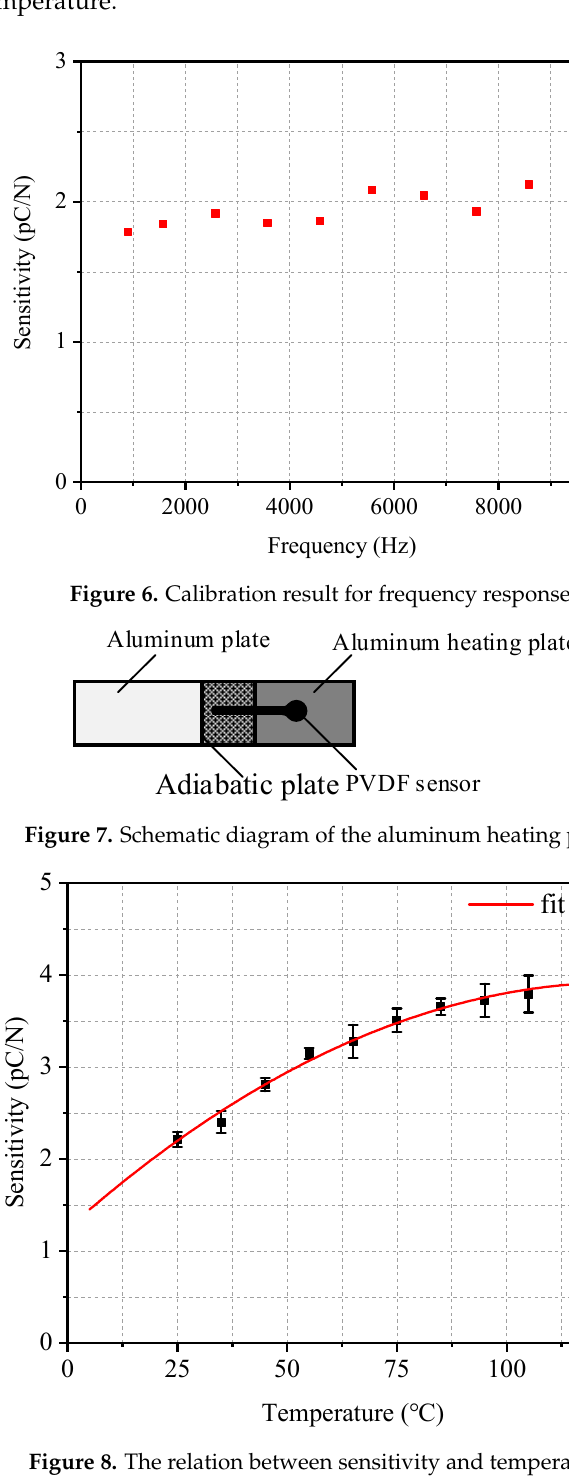
Figure 8. The relation between sensitivity and temperature.